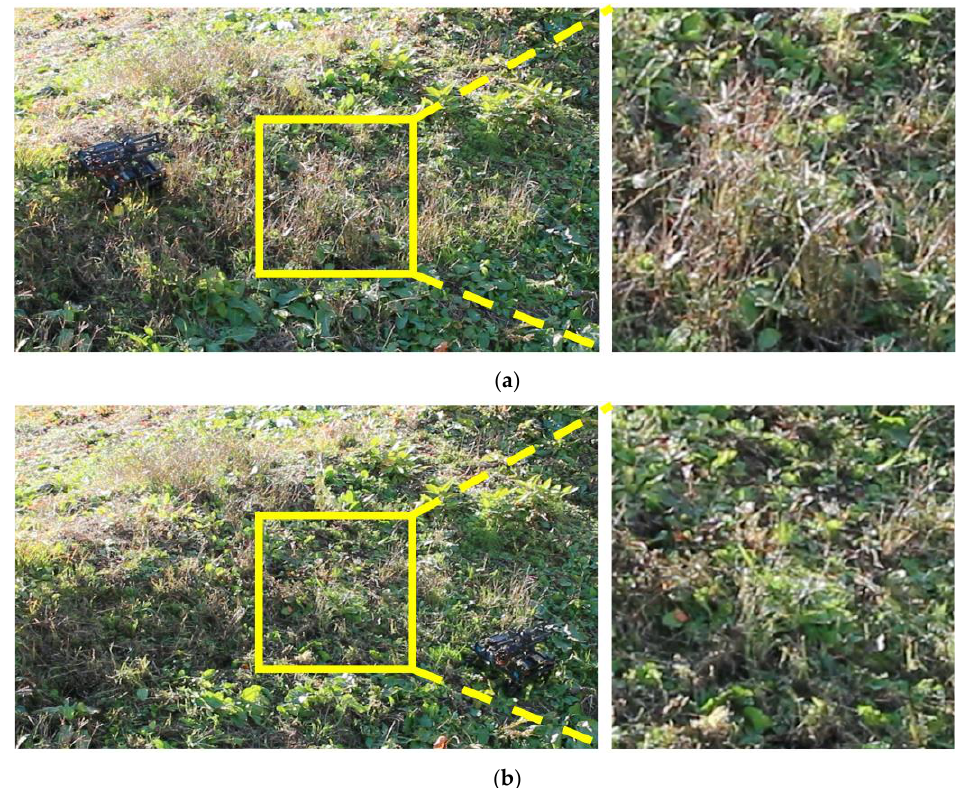
Figure 18. Grass cutting at different sites (slope angle 18 – 40°). ( a ) Before cutting the grass. ( b ) After cutting the grass.